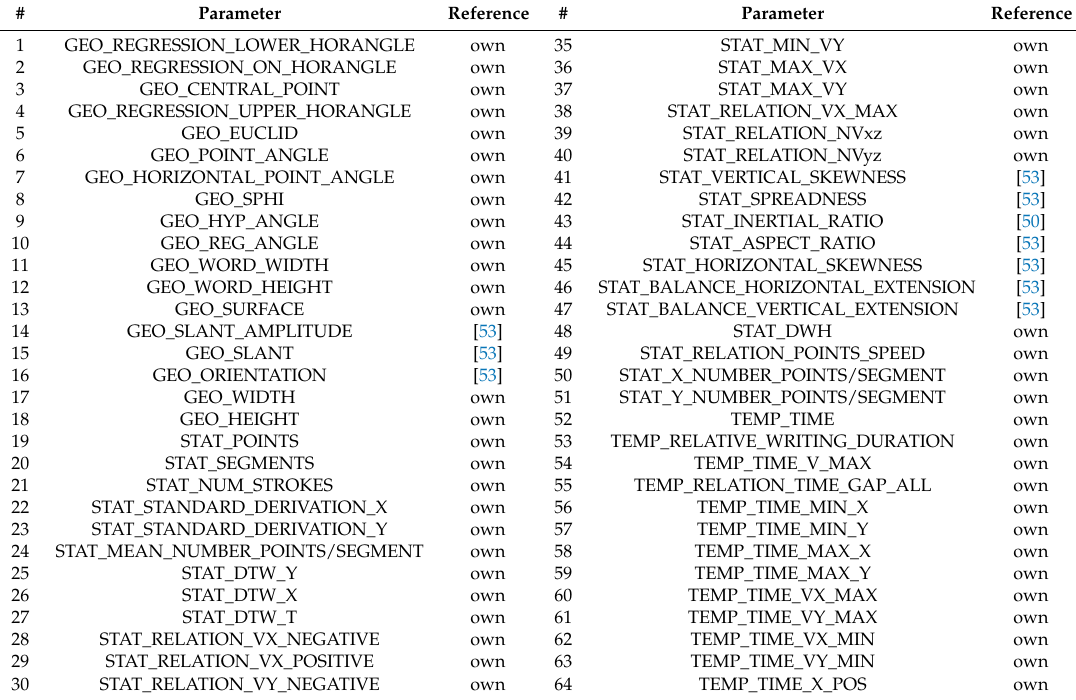
Table 1. All features used in this work with their numbers and